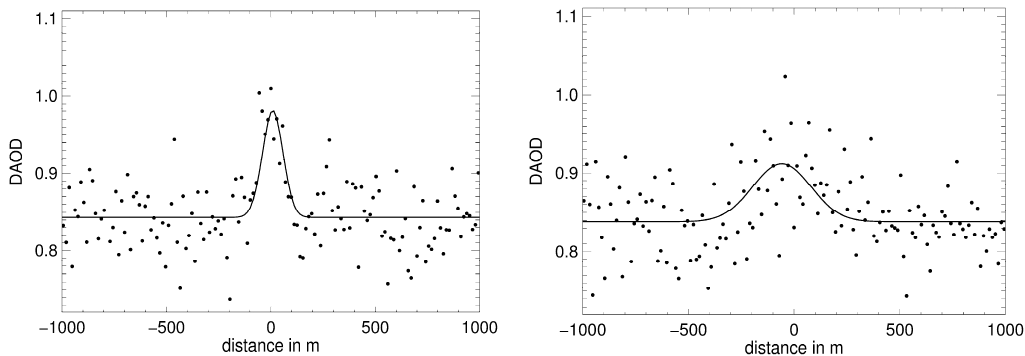
Figure 7. Exemplary IPDA Lidar measurements across artificial Gaussian CO 2 plumes with 5% random noise (dots), for a distance of: 1 km from the point source ( left ); and 2 km from the point source ( right ). Lines: Results of the fit of the sum of a Gaussian and a constant background to the noisy DAOD which extend across 10 km. The integral of the DAOD enhancement A y (Equation (5)) corresponds to the area below the peak, background subtracted. Assumed emission rates and auxiliary parameters are listed in Table 4. These modeled examples compare well with the measurements by [18].